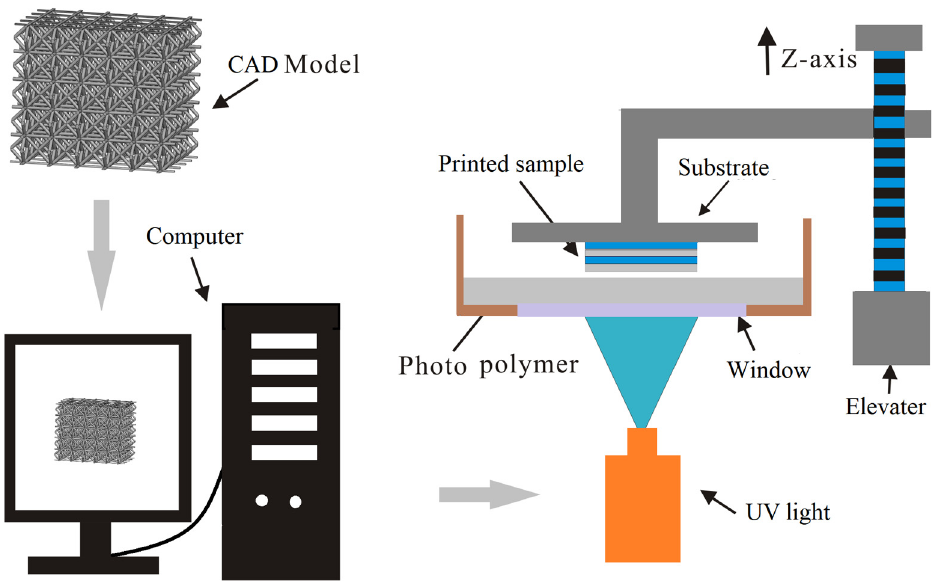
Figure 2. Schematic of a typical additive manufacturing process using an Autodesk Ember 3D printer.